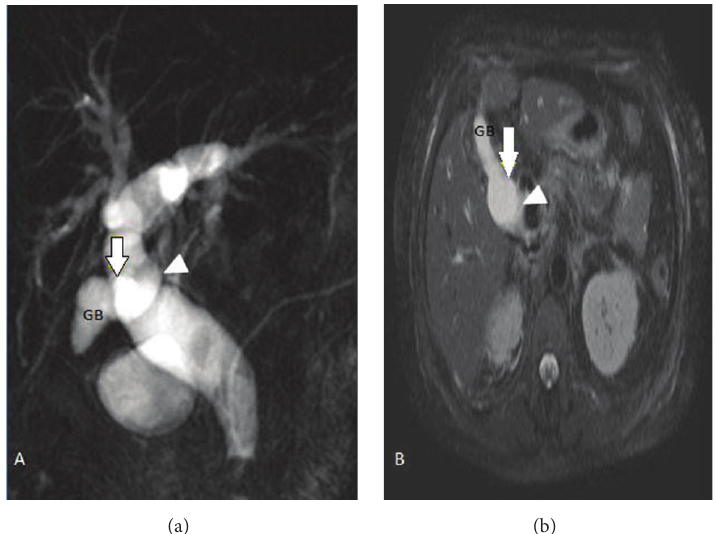
Figure 6: (a) Coronal oblique 3D MR cholangiopancreatography. (b) SSH SPAIR transverse image shows short cystic duct with anterior insertion (arrow) into the CHD (arrowhead). GB: gall bladder.